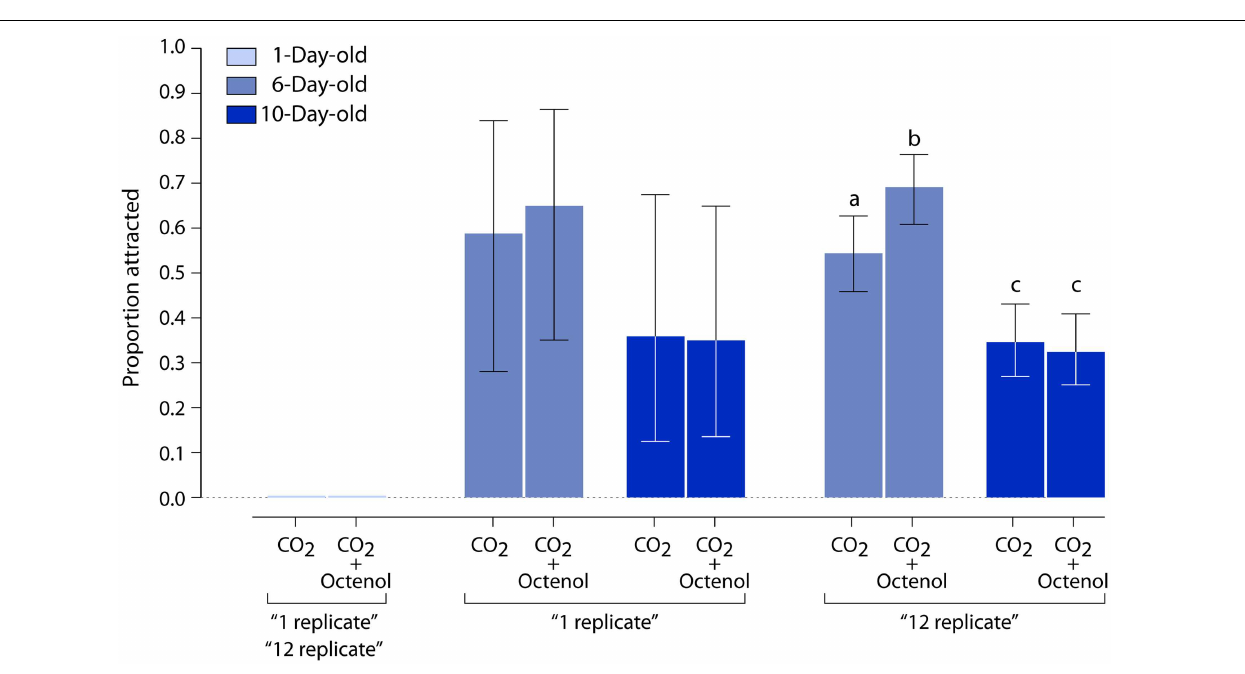
attraction to both CO 2 and CO 2 + octenol.Ten day old animals exhibit lower CO 2 activation and no attraction to CO 2 + octenol.Vertical bars represent 95% confidence